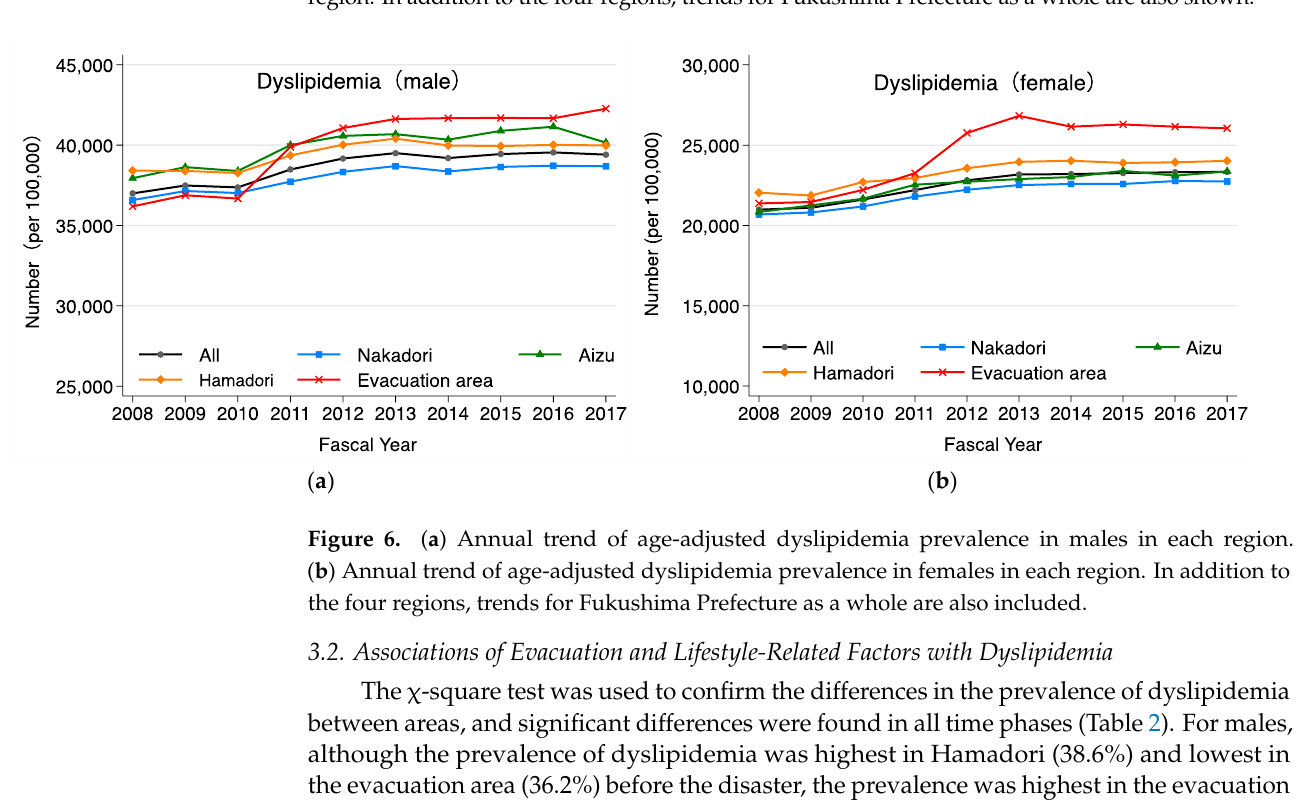
Figure 5. ( a ) Annual trend of age-adjusted rate of cholesterol-lowering medication use for males in each region. ( b ) Annual trend of age-adjusted rate of cholesterol-lowering medication use for females in each region. In addition to the four regions, trends for Fukushima Prefecture as a whole are also shown.